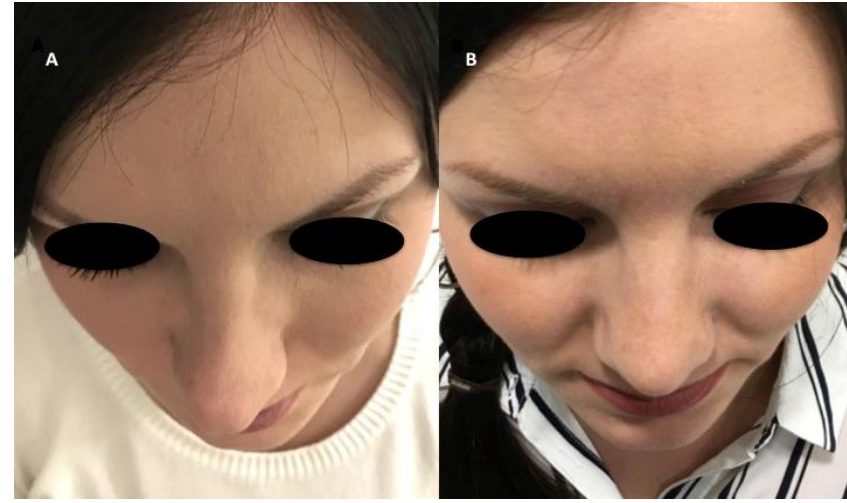
Figure 6. 43-year-old female patient affected by nasal obstruction and minor soft tissue defects in detail projection. ( A ) External nose analysis showed better-left nose deviation, external nasal valve collapse, deficit of supra tip projection, deficit of radix and dorsum volume. Anterior rhinoscopy showed a deviated nasal septum and the bilateral stenosis of the internal valves. ( B ) The fluid